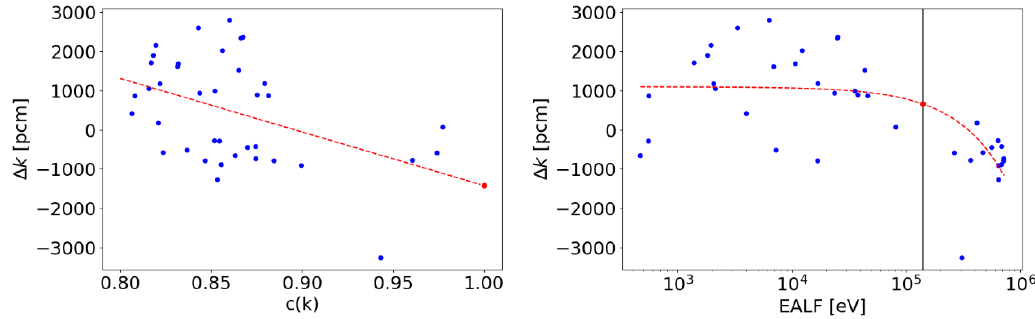
Figures 3e and 3f. The updated error between the model and the corresponding experiment as a function of c